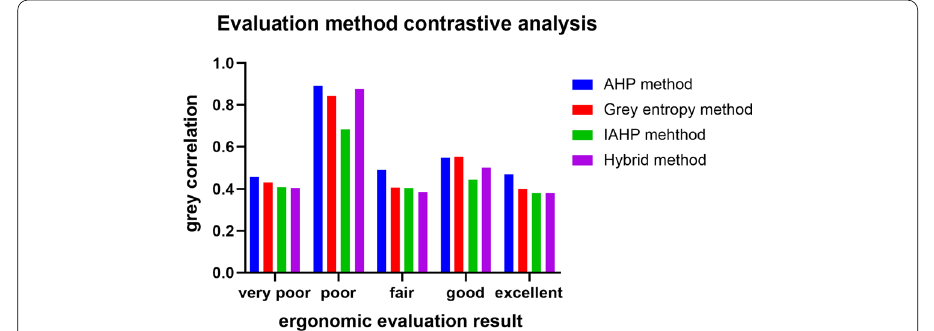
Fig. 8 Contrastive analysis of the four methods evaluation